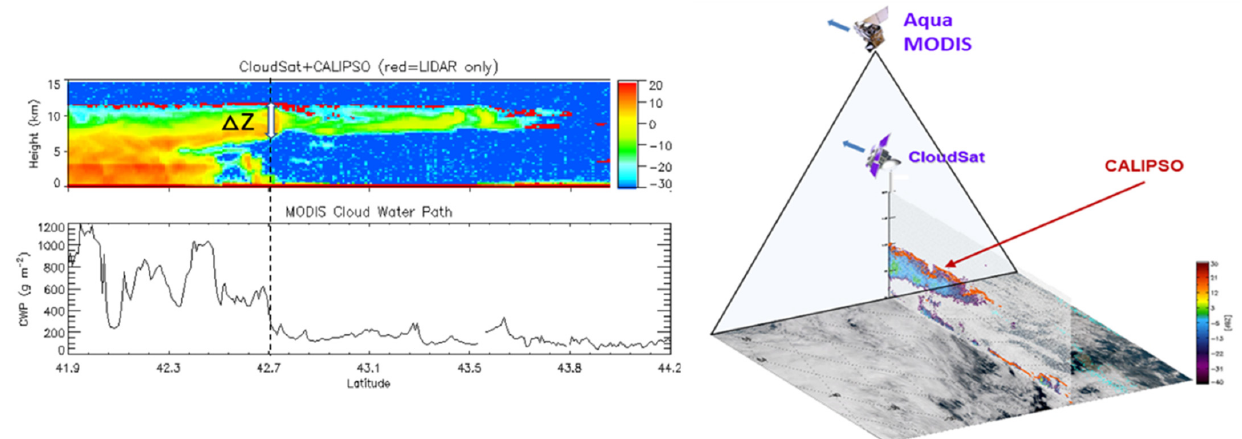
Figure 1. Sample of space-borne active-passive sensor data combinations for the CBH algorithm development using A-Train satellite data (Aqua MODIS and CloudSat/CALIPSO).